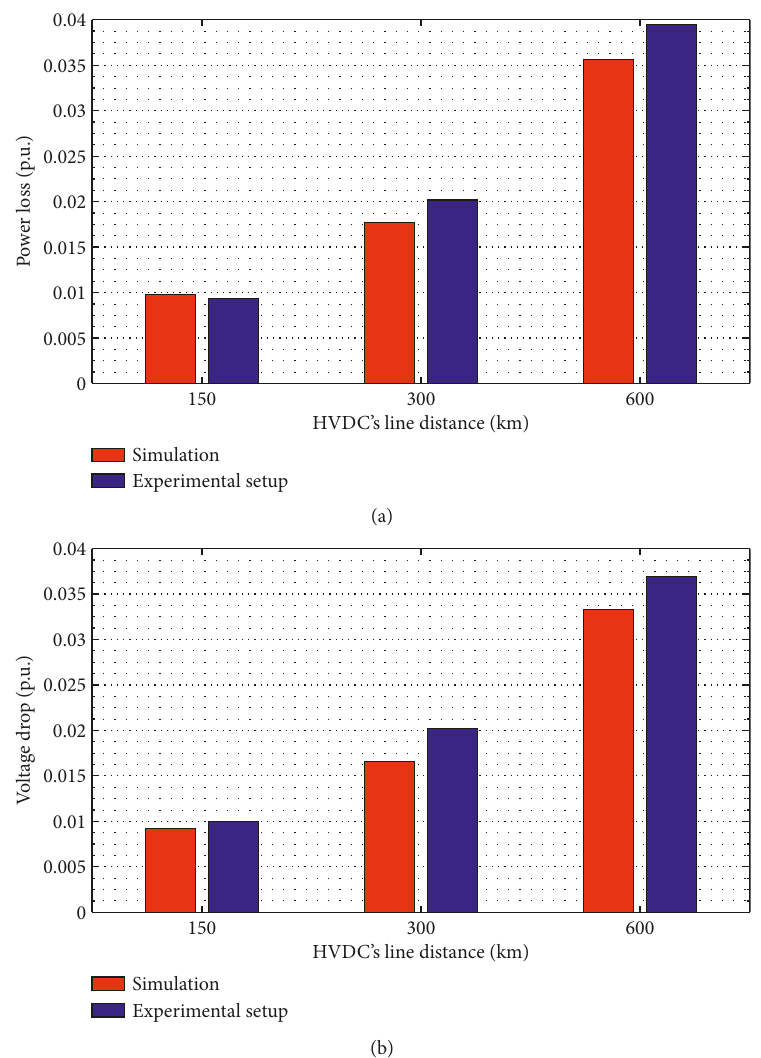
Figure 14: Comparison of the current waveforms based on transmission line distance conditions. (a) Comparison of the power losses and (b) comparison of the voltage